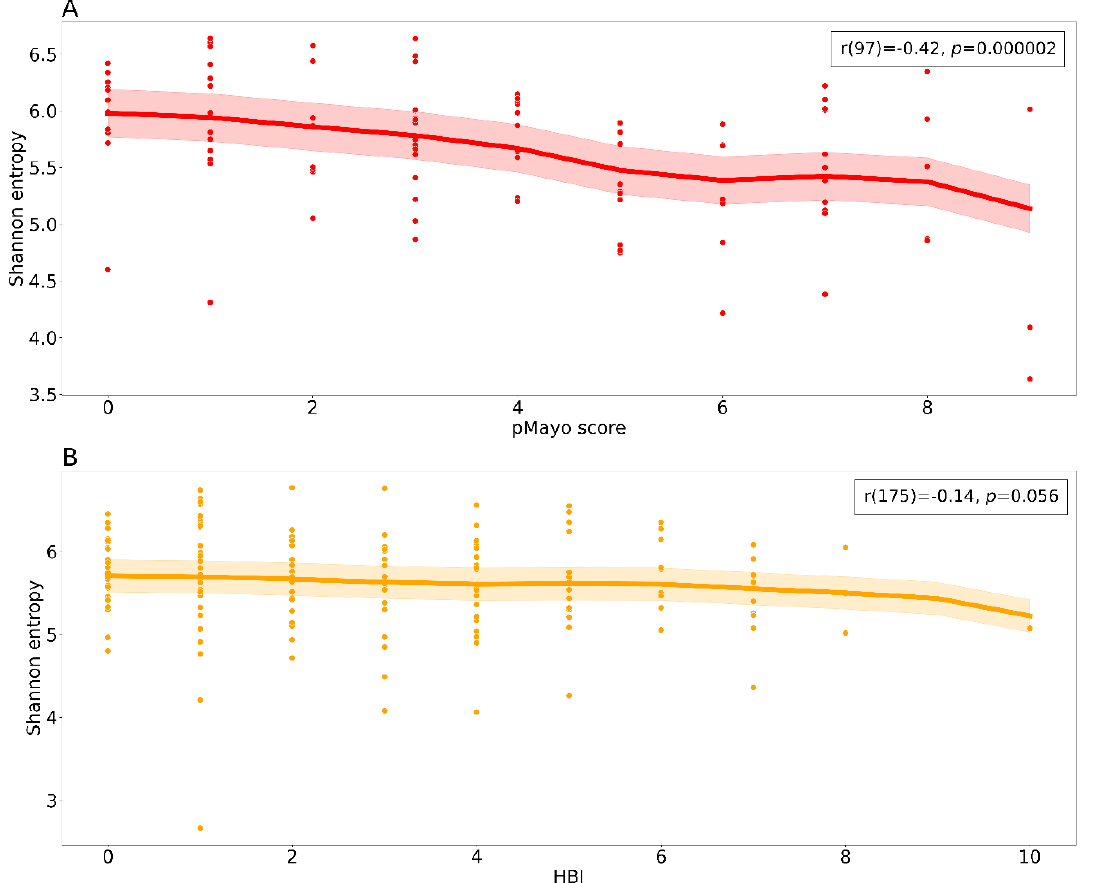
Figure 3. Relationship between alpha diversity and clinical scores. The scatter plots show a negative correlation between the clinical scores and Shannon entropy for both diagnostic groups ( A ) ulcerative colitis and ( B ) Crohn’s disease. Each dot represents a sample from a patient at a specific time point including the baseline. The bold lines represent locally weighted regression with a confidence interval fill. Spearman correlation results are reported in the upper right box. Abbreviations: pMayo, partial Mayo score; HBI, Harvey – Bradshaw index.